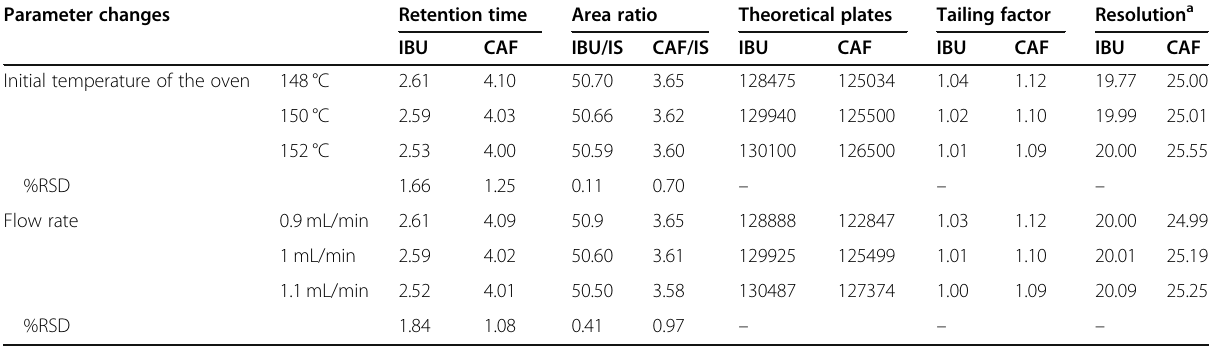
Table 5 Robustness of the method Parameter changes Retention time Initial temperature of the oven